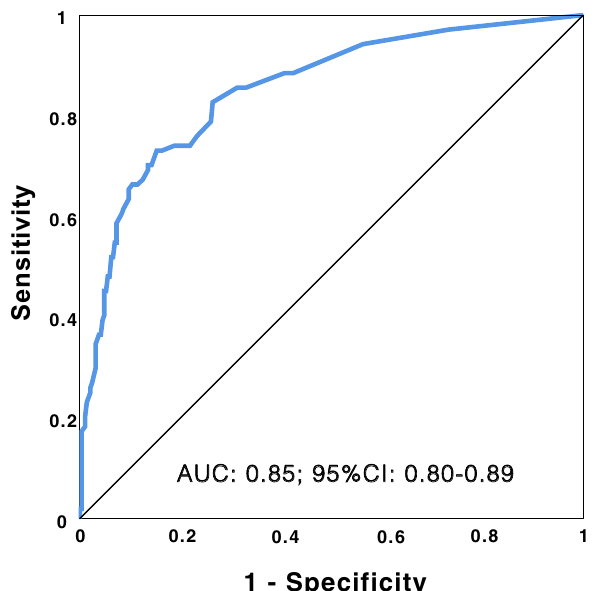
Figure 3. ROC curve of the severe disease prediction model.